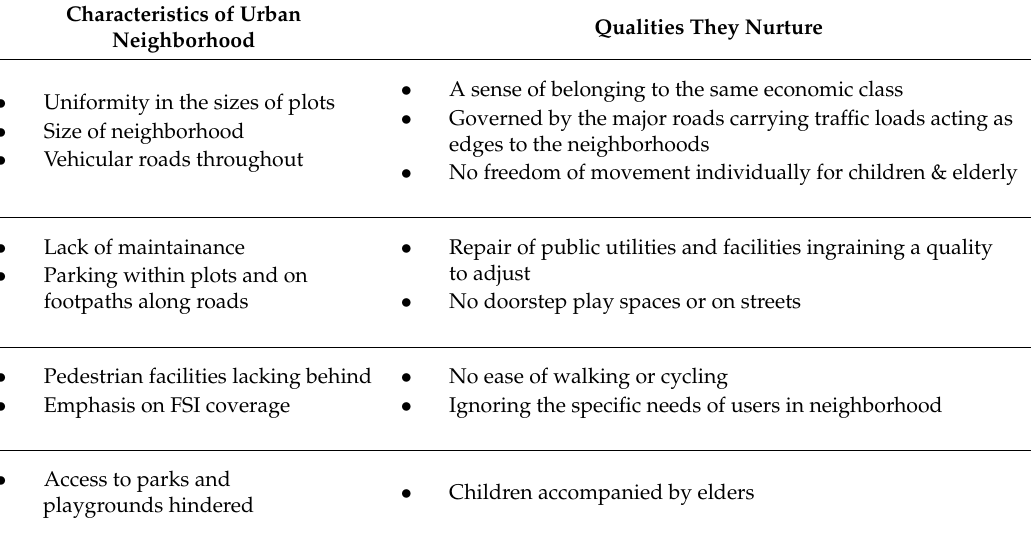
Table 2. Characteristics of neighborhood and qualities they